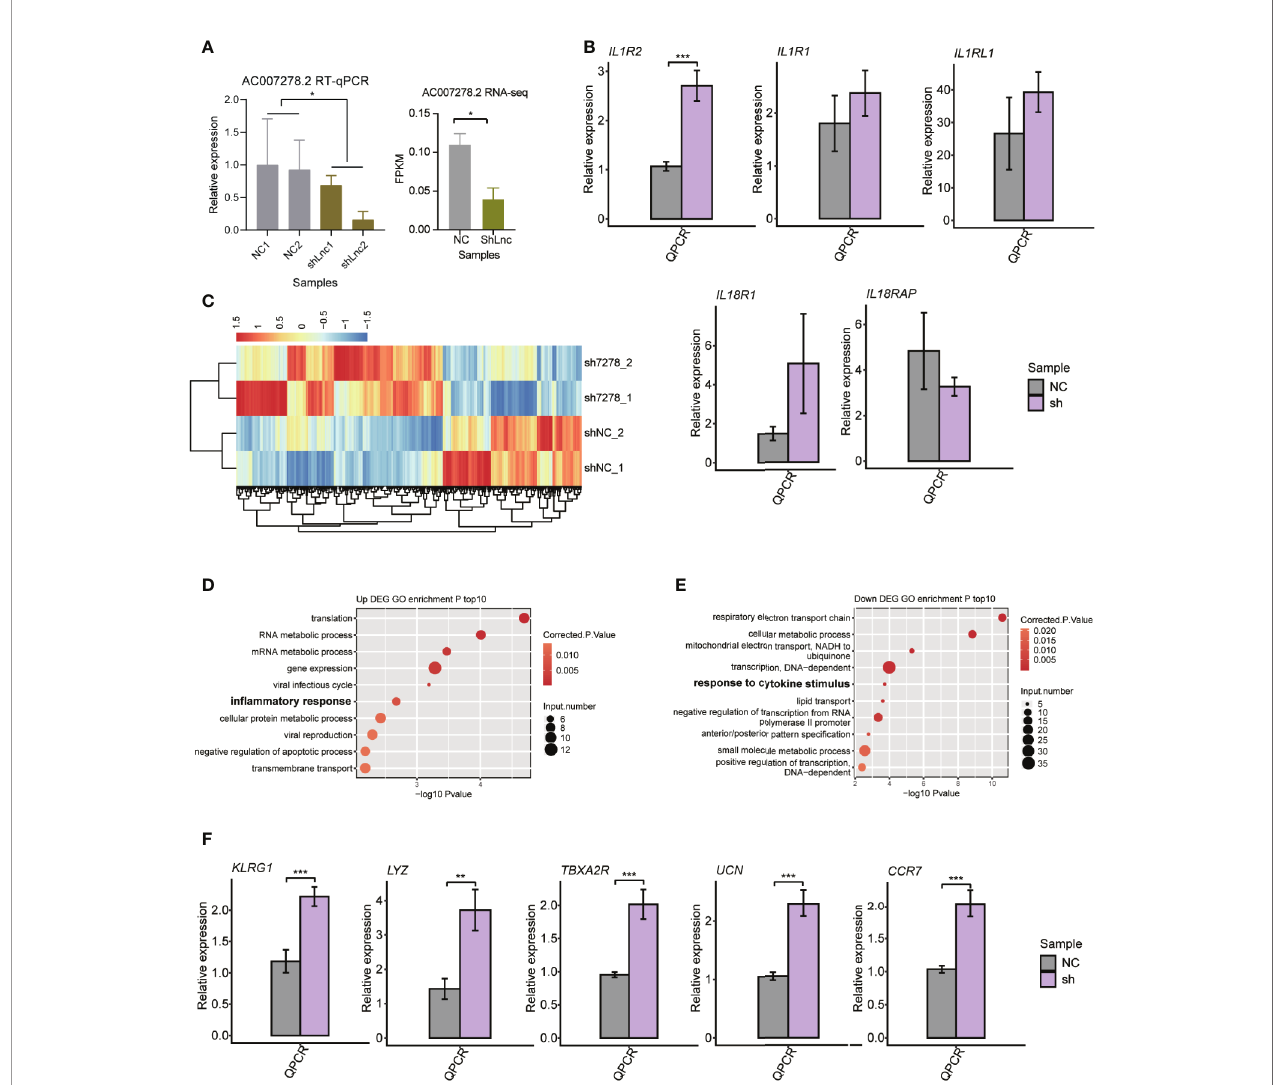
FIGURE 5 | The transcriptional regulation of AC007278.2 is observed by the knockdown experiment. (A) Bar plot shows the quantitative reverse-transcription polymerase chain reaction (RT-qPCR) experiment (left panel) and RNA-seq (right panel) results of repressed AC007278.2 expression due to the short hairpin RNA (shRNA) knockdown experiment (mean ± SD). (B) Bar plot shows RT-qPCR experiment results of the fi ve adjacent gene expression levels in the normal control and sh- AC007278.2 samples (mean ± SD). (C) Hierarchical clustering heat map shows the differentially expressed genes regulated by AC007278.2 . (D) Bubble plot shows the top 10 enriched Gene Ontology (GO) biological process (BP) terms for genes that were up-regulated by AC007278.2 knockdown. (E) Bubble plot shows the top 10 enriched GO BP terms for genes that were down-regulated by AC007278.2 knockdown. (F) Bar plot shows RT-qPCR experiment results of the fi ve in fl ammatory response-related genes that were up-regulated by AC007278.2 knockdown (mean ± SD). * p < 0.05; ** p < 0.01; *** p < 0.001; two-tailed unpaired t -test. N.s. represented non-signi fi